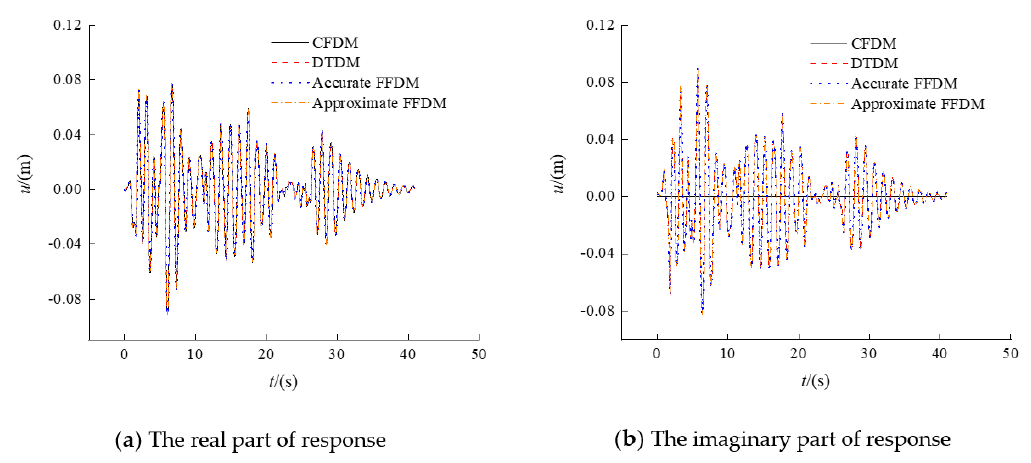
Figure 7. Displacement time history under El Centro excitation. Table 3. The relative errors of the amplitude of displacements under El Centro excitation (%).